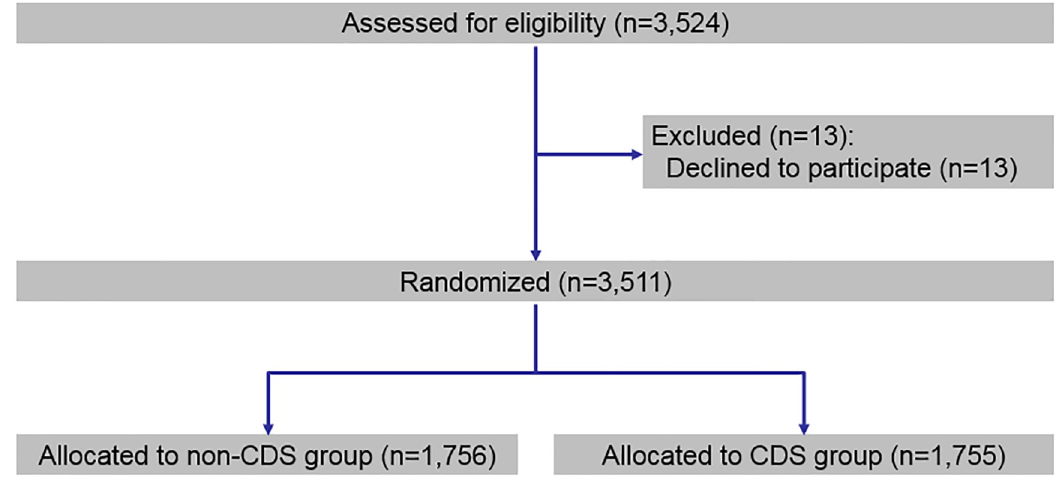
Fig 1. CONSORT flow